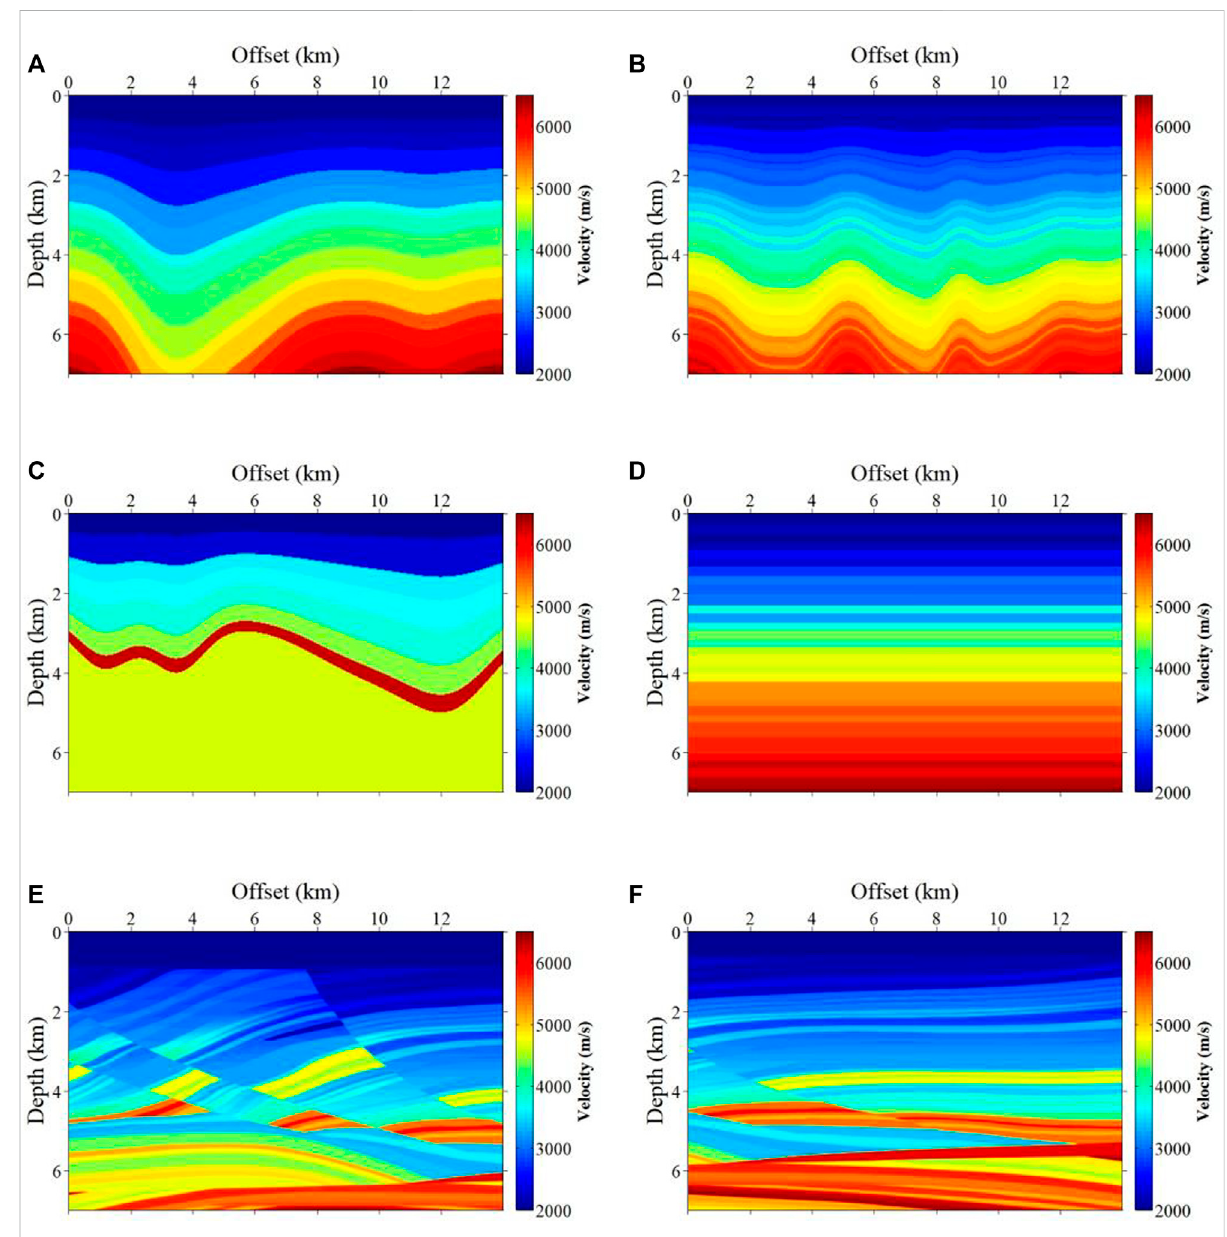
FIGURE 1 Sixrepresentativeself-generatedvelocitymodelswithdifferentgeologicalstructures. (A) representsthehorizontallayeredmodels; (B) refersto the curved layered models; (C) denotes the models featured with thick and reverse layers; (D) is the models with a high-speed anomaly. (E) and (F) represent the cropped section from the Marmousi